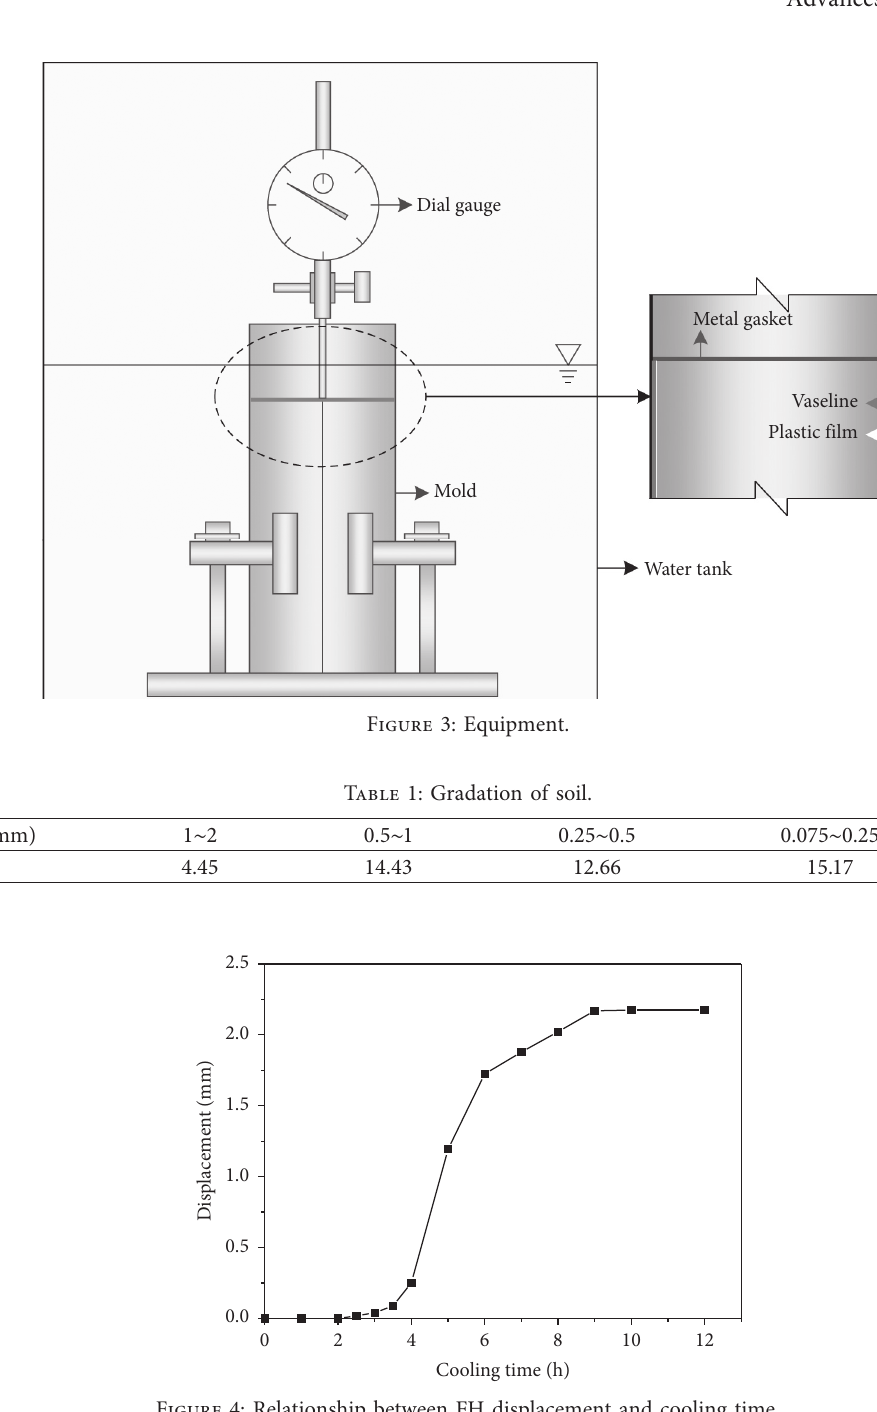
Figure 4: Relationship between FH displacement and cooling time.